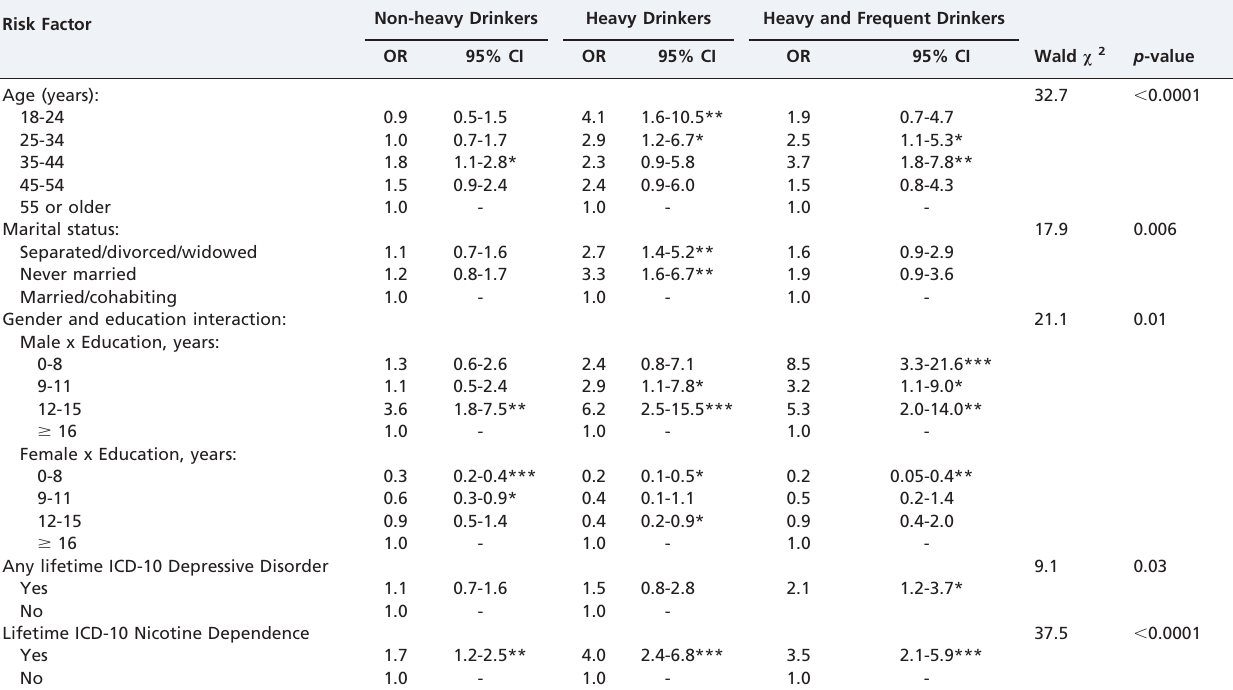
Table 4 - Predictors of drinking patterns: demographic variables, lifetime nicotine dependence and lifetime depression, presented as adjusted odds ratios (ORs) and 95% CI. Final model of polychotomous logistic regression; Wald x 2 (n = 1,464;